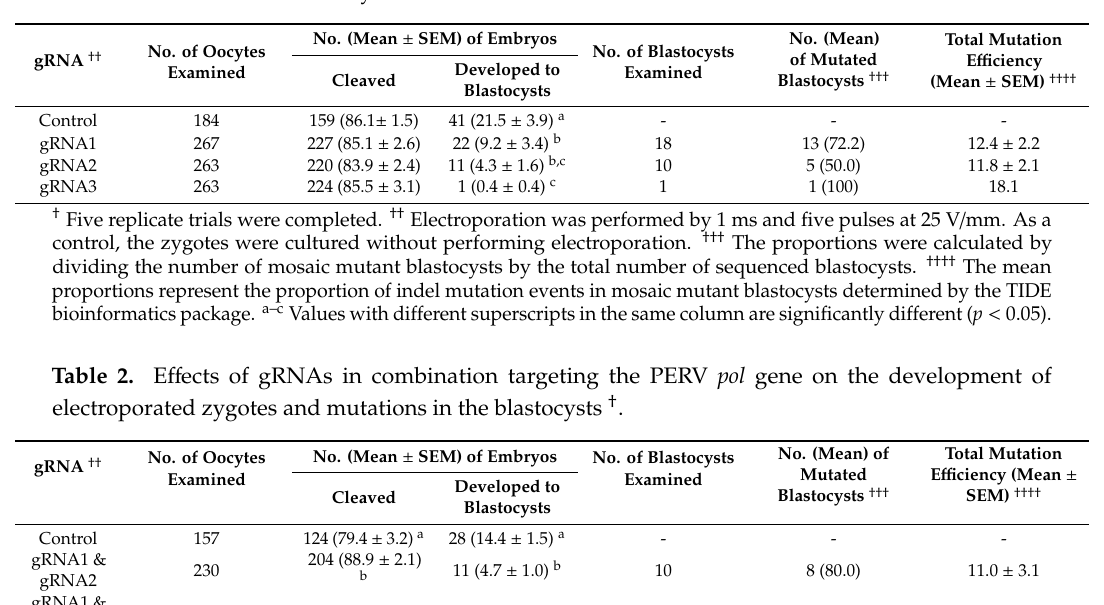
Figure 3. Representative result of Sanger sequencing analysis after the introduction of gRNA targeting the PERV pol gene and Cas9 protein, and the frequencies of indel mutation quantified by a Tracking of Indels by Decomposition (TIDE) analysis. Sanger sequencing results obtained from the blastocysts developed after the introduction of gRNA# 1 are shown. ( a ) Analysis of wild-type blastocyst. ( b , c ) Analysis of the genome-edited blastocyst. Example of the result showing relatively low (b; 9.4% of 1 bp insertion) or high (c; 21.0% of 1 bp insertion) indel frequency. Arrowhead indicates the Cas9 cleavage site. Nucleotides in blue color indicate target sequence of PERV#1 gRNA, and nucleotides in red color indicate protospacer adjacent motif (PAM) sequences. Table 1. E ff ects of gRNA targeting the PERV pol gene on the development of electroporated zygotes and the mutation in the blastocysts † .